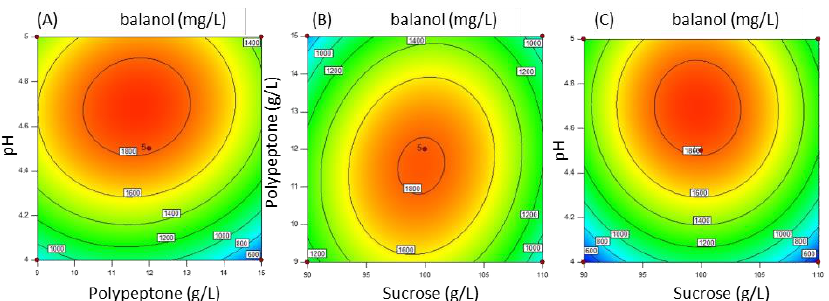
Figure 8. Contour plots for response interaction between two variables. ( A ) Interaction effect of pH and polypeptone on balanol production; ( B ) Interaction effect of sucrose and polypeptone on balanol production; ( C ) Interaction effect of pH and sucrose on balanol production.